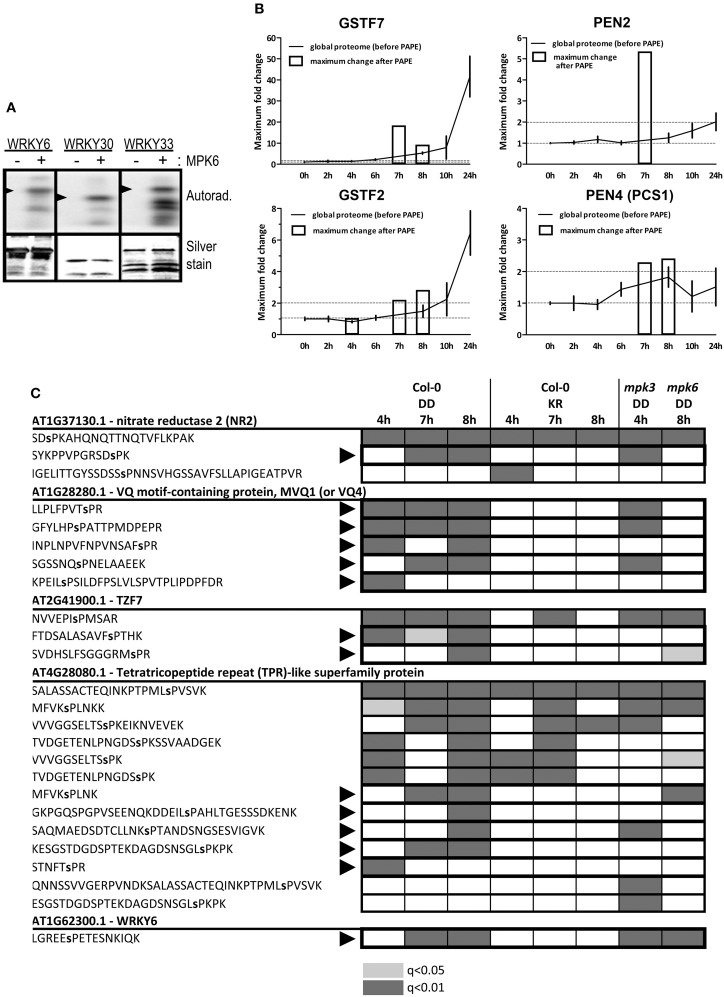
Validation of phosphorylation of the identified putative substrates. (A)
In vitro kinase assay using recombinant MPK6 and recombinant His-tagged WRKY proteins as substrates in the presence of γ−32P-ATP. Phosphorylated substrates are visualized by phosphor-imaging (top panel) and equal loading determined by silver staining of the gels (bottom panel). Arrowheads mark the position for the expected size of the full-length proteins (smaller protein bands are presumably from partial or degradation products). (B) Comparison of protein levels before and after the PAPE procedure for selected putative substrates/phospho-proteins. The relative fold phospho-protein enrichment after PAPE (between the Col-0 DD and the Col-0 KR plants) for the 4, 7, and 8 h time points after DEX treatment (white bars) were superimposed over the protein levels detected over the 24 h global proteome analysis. (C) Phosphorylation of SP/TP motifs within selected putative MAPK substrates. Proteome Discoverer 1.4 was used to consolidate the data from different experiments. The shadings denote the detection of the indicated phosphopeptides (gray: q < 0.01 or light gray: q < 0.05). Black arrowheads mark the phosphopeptides that are only detected in the Col-0 DD but not the KR lines. The phosphorylated residues are indicated as small letters within the peptide sequence.